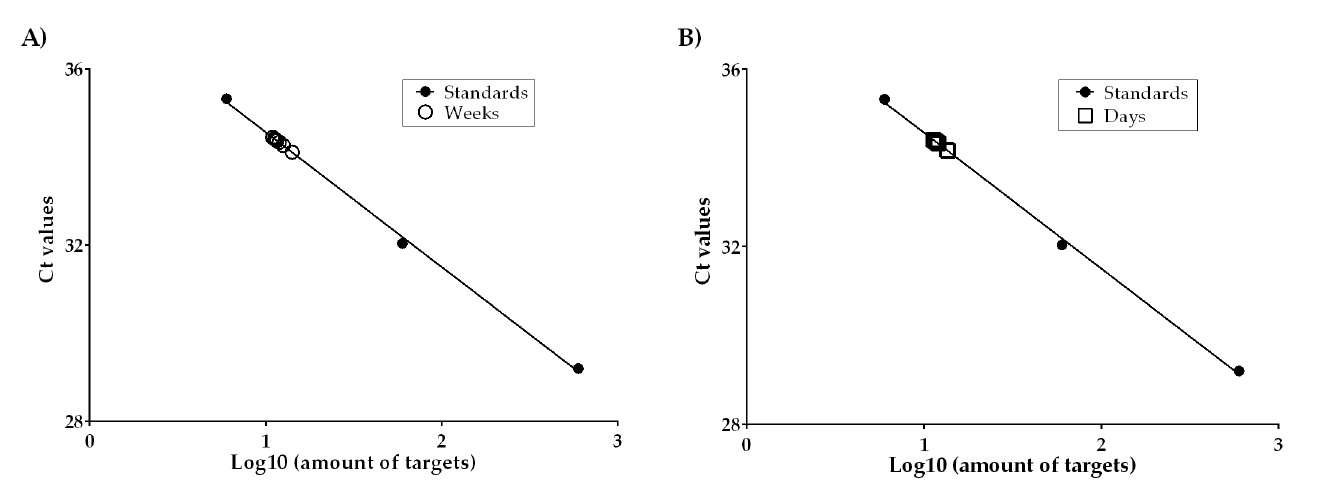
Fig 3. Mean ITS target number of quantifiable weekly and daily air samples for Es . africanus fit on the standard curve. Note: Five standards were used to generate the standard curve; however, only three standards are shown in these figures to increase the visibility and separation of the test samples. A) Weekly air samples B) Daily air